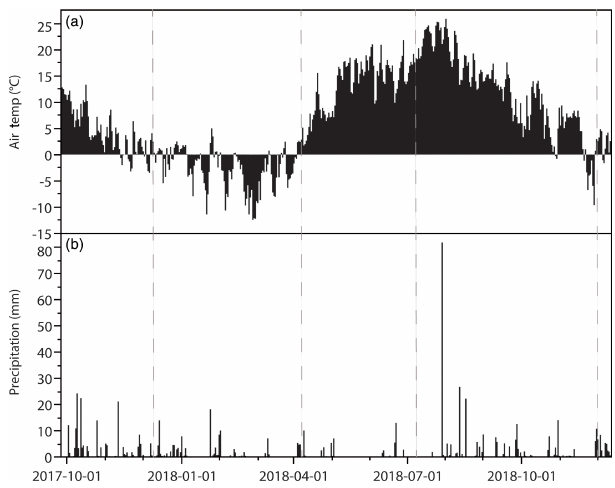
Figure 2. (a) Daily mean air temperature, and (b) daily precipitation during the study period (26 September 2017–12 December 2018) at the Marsta observatory. Due to malfunctioning sensor the precipita- tion data for 29 July 2018 is collected from the nearby (3km) SMHI station, Ärna. The dotted lines refer to the hydrological periods dis- played in Fig.